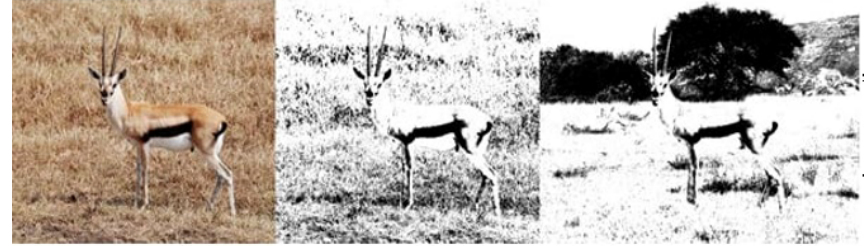
Figure 7. Example of the counter-shadow phenomenon on Gazelle [4].